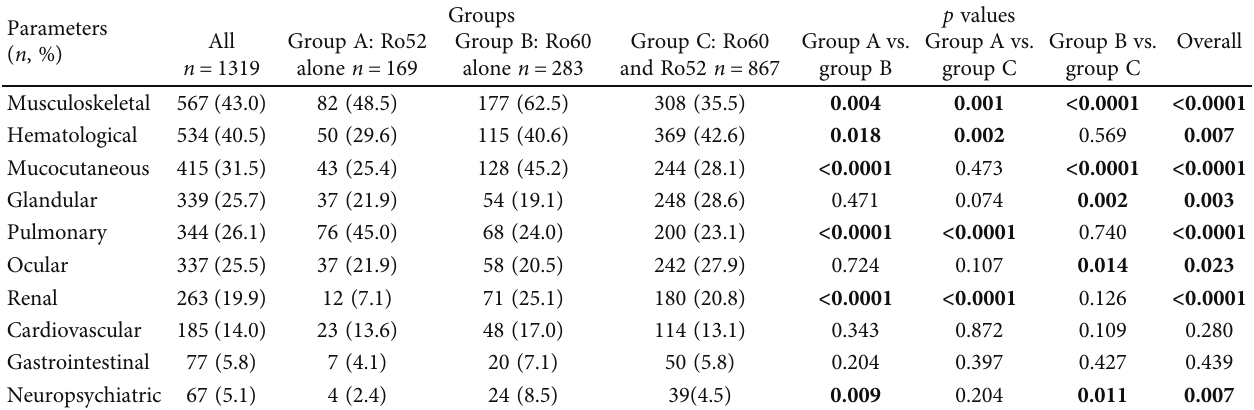
Table 4: Comparison of organ involvement in patients with connective tissue